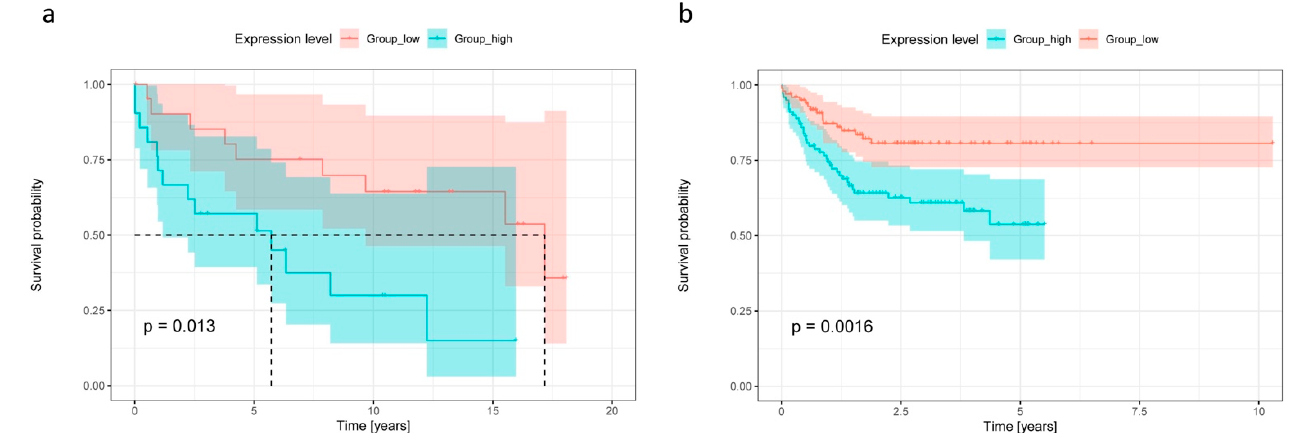
Figure 5. Overall survival in relation to chemokine receptor expression of the two aggressive lymphoma cohorts. Kaplan–Meier plot showing the overall survival of all de novo DLBCL and tFL patients, split into two groups based on the level of CCR7 expression (high CCR7 expression in blue, low expression in red, split by median). Survival curves of the de novo DLCBL and tFL cohorts are shown in ( a ). Survival curves of publicly available mRNA dataset Lenz et al. [21] (E-GEOD-10846 dataset available from ArrayExpress) is presented in ( b ).